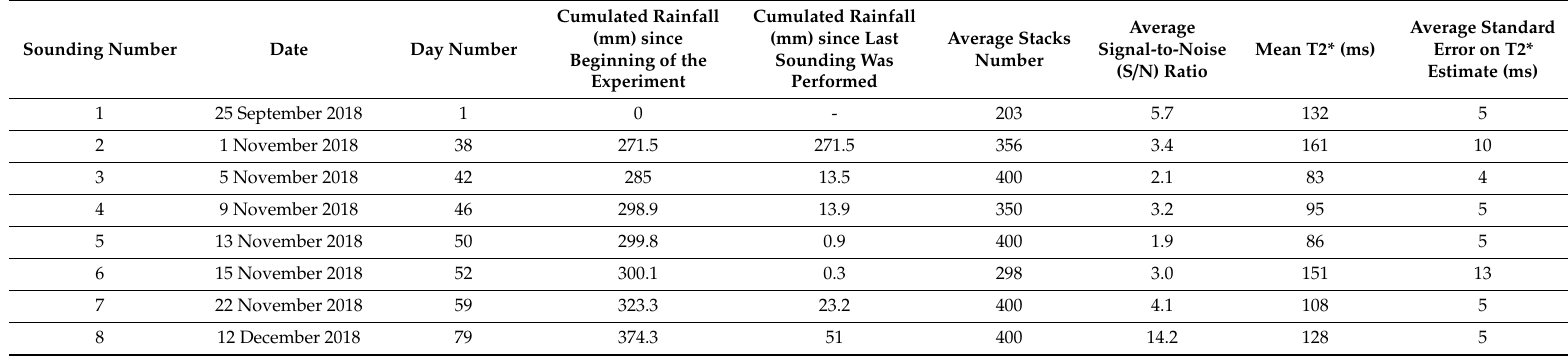
Table 1. Synthesis of SNMR